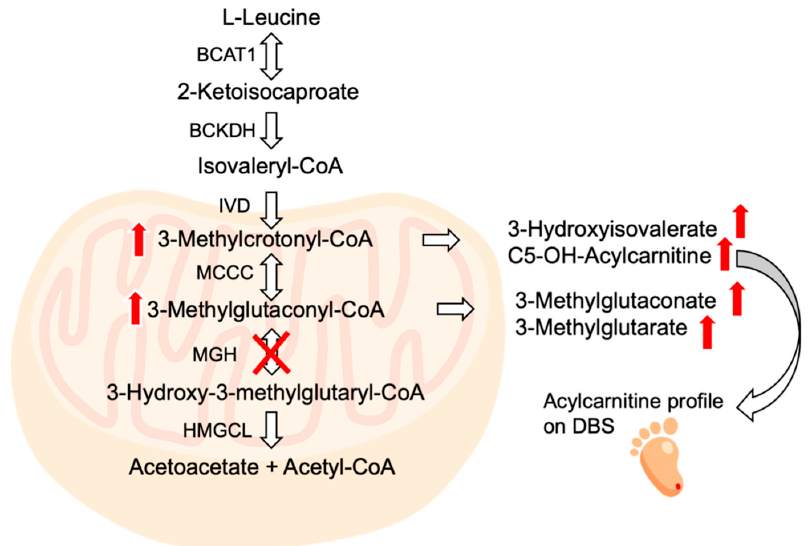
Figure 1. Illustration of the leucine catabolic pathway. BCAT1, branched-chain amino acid aminotransferase 1; BCKDH, branched-chain α -keto acid dehydrogenase complex; IVD, isovaleryl-CoA dehydrogenase; MCCC, 3-methylcrotonyl-CoA carboxylase; 3-MGH, 3-methylglutaconyl-CoA hydratase; HMGCL, 3-hydroxy-3-methylglutaryl-CoA lyase; 3-HIVA, 3-hydroxyisovaleric acid; DBS, dried blood spot [4].